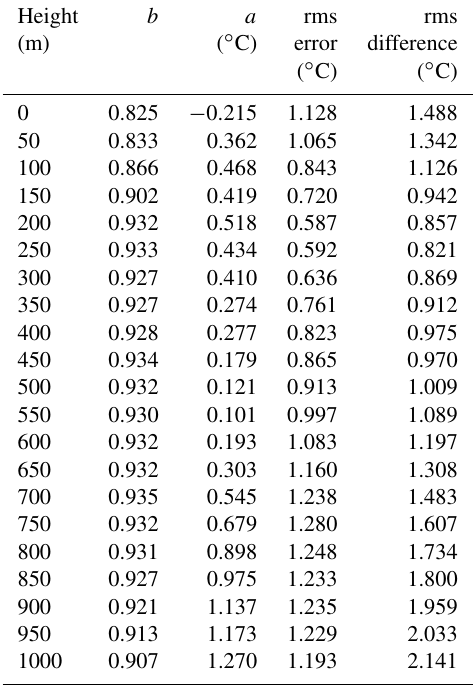
Table 4. Parameters from linear regression between temperatures from radiosonde ascents ( x ) and temperature profiler ( y ): slope b , y axis offset a , rms fit error, and rms of temperature differences. As the model is built up of 60 layers, the temperature and humidity files comprise 60 columns and the pressure file 61 columns, since temperature and humidity are given within the layers and the pressure at the layer boundaries. Each